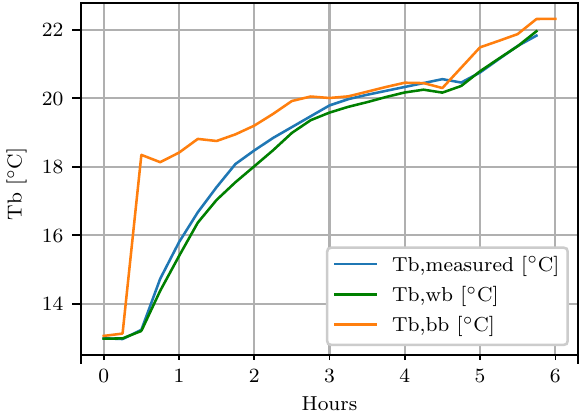
Figure 8. Water basin temperature response for a fan state